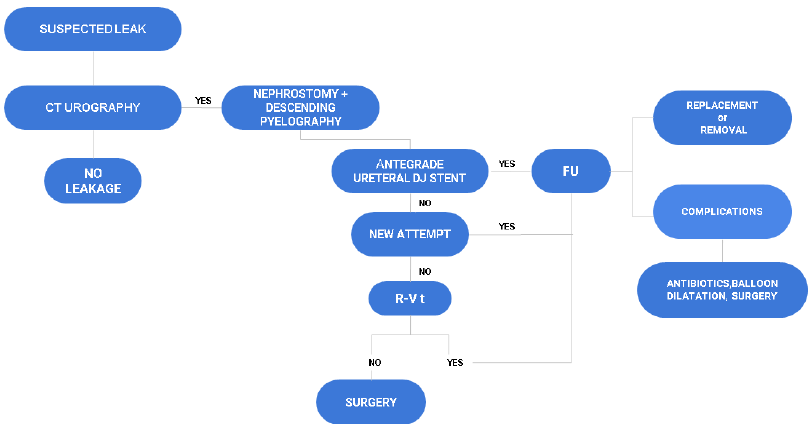
Figure 4. Management algorithm for iatrogenic ureteral injuries. CT: computed tomography; DJ: double J; FU: follow up; R-V t: rendezvous technique.